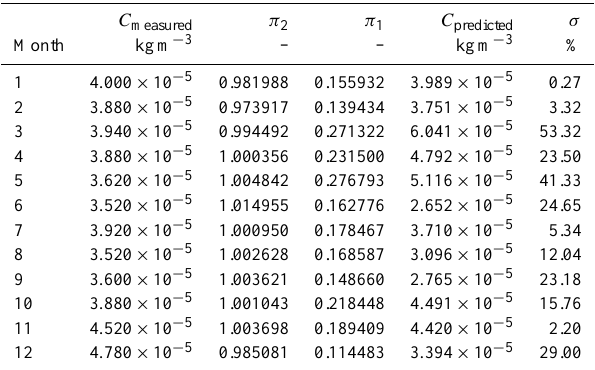
Table 3. Values of non-dimensional arguments, predicted concen- trations, uncertainty for phosphorus.